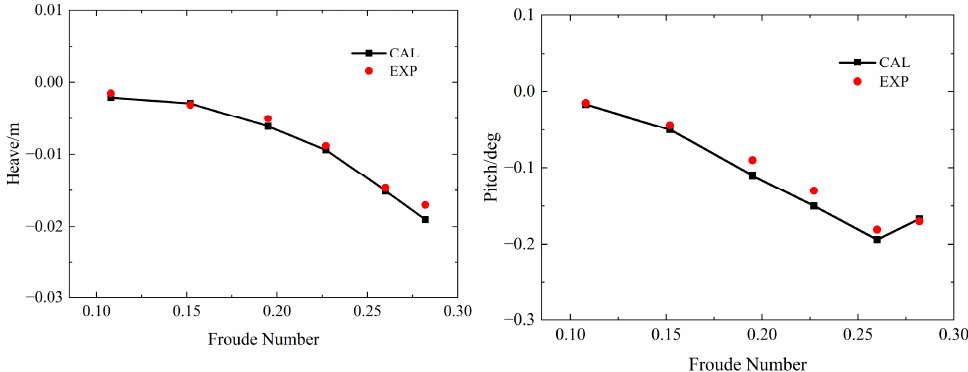
Figure 11. Comparison of heave and pitch of KCS.